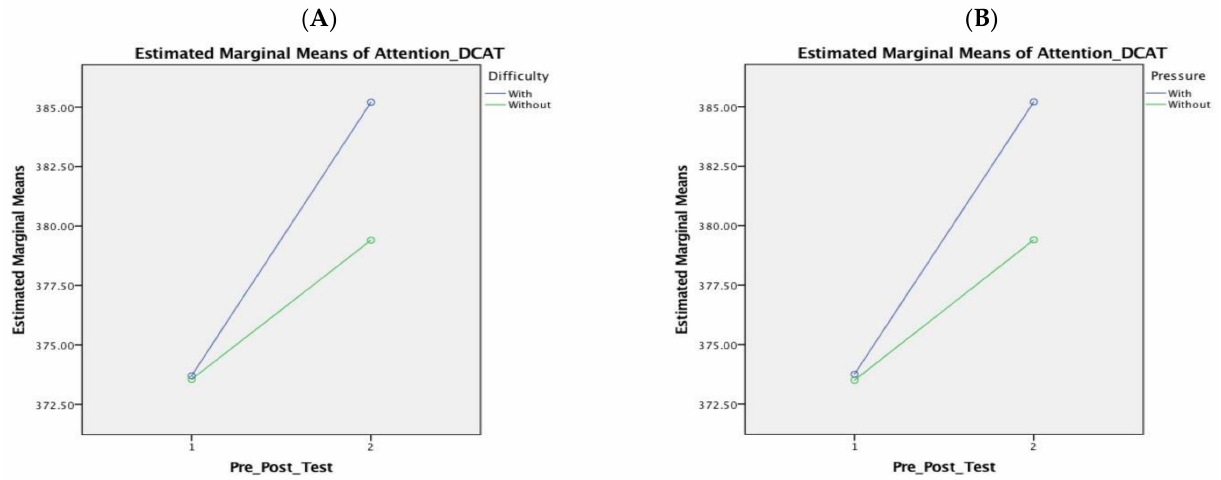
Figure 6. The graph of two-factor interaction in D-CAT. Figure ( A ) shows the interaction of pre/post- test * difficulty; Figure ( B ) shows the interaction of pre/post-test * pressure. Note: pre/post-test (the horizontal axis); pre-test = 1 and post-test = 2.